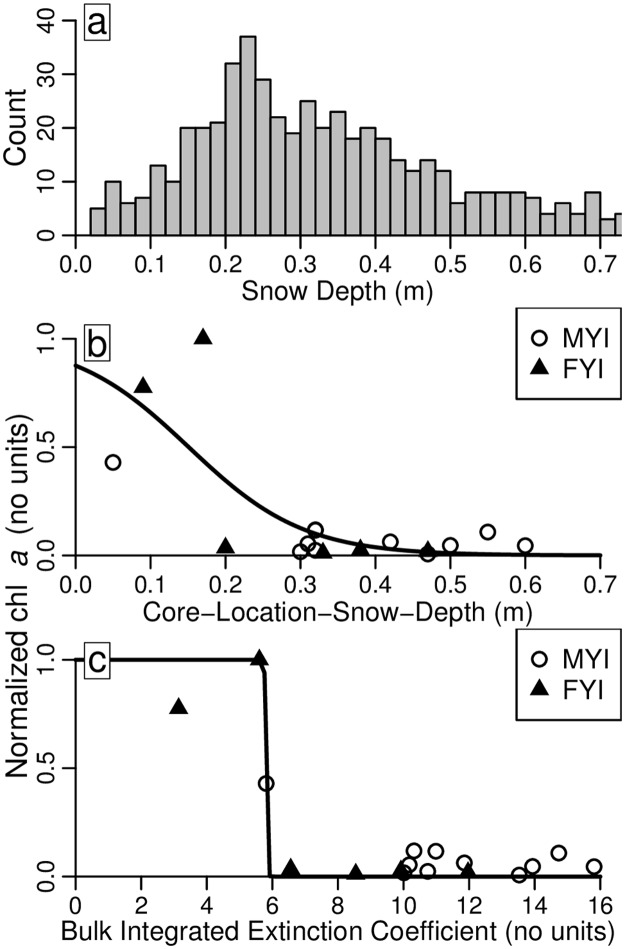
Snow histogram and logistic regressions.a) Histogram of snow depth survey measurements at MYI sites (n = 538). Logistic regressions of normalized bottom-integrated chl a concentrations as a function of: b) snow-depth at core locations; and c) bulk (snow plus ice) integrated extinction coefficients.